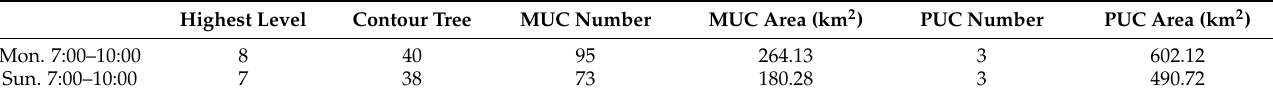
Table 5. Basic information on urban centers on Monday and